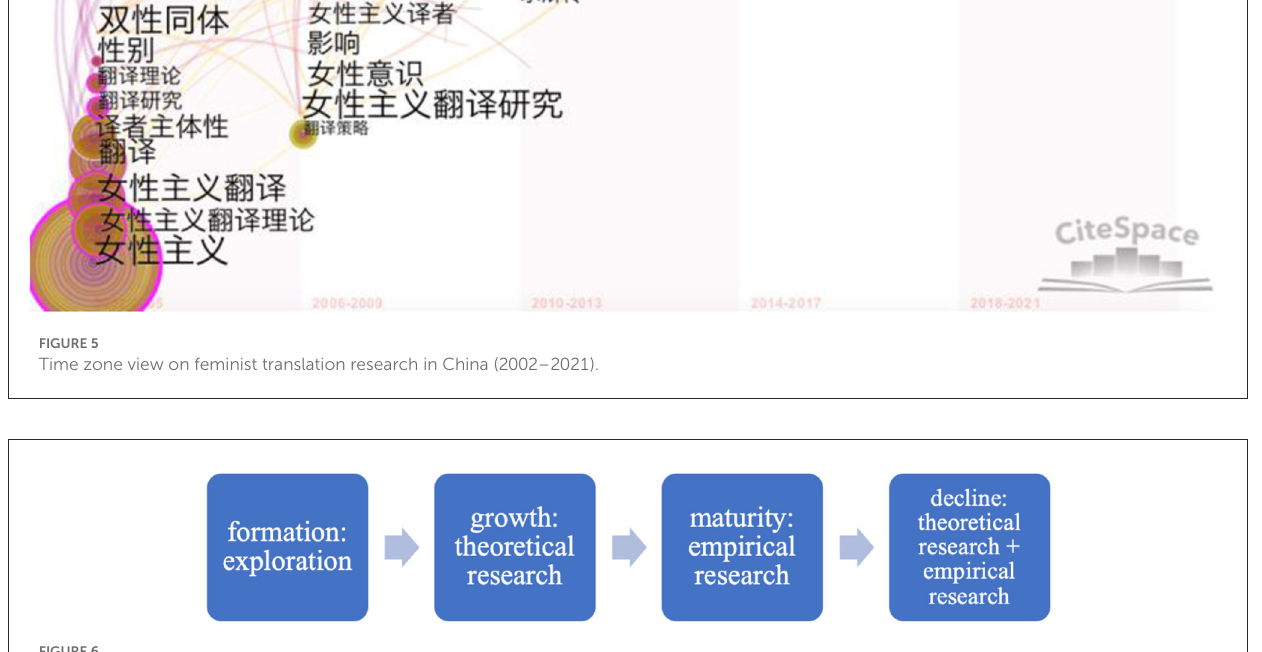
FIGURE6 Characteristics of different time